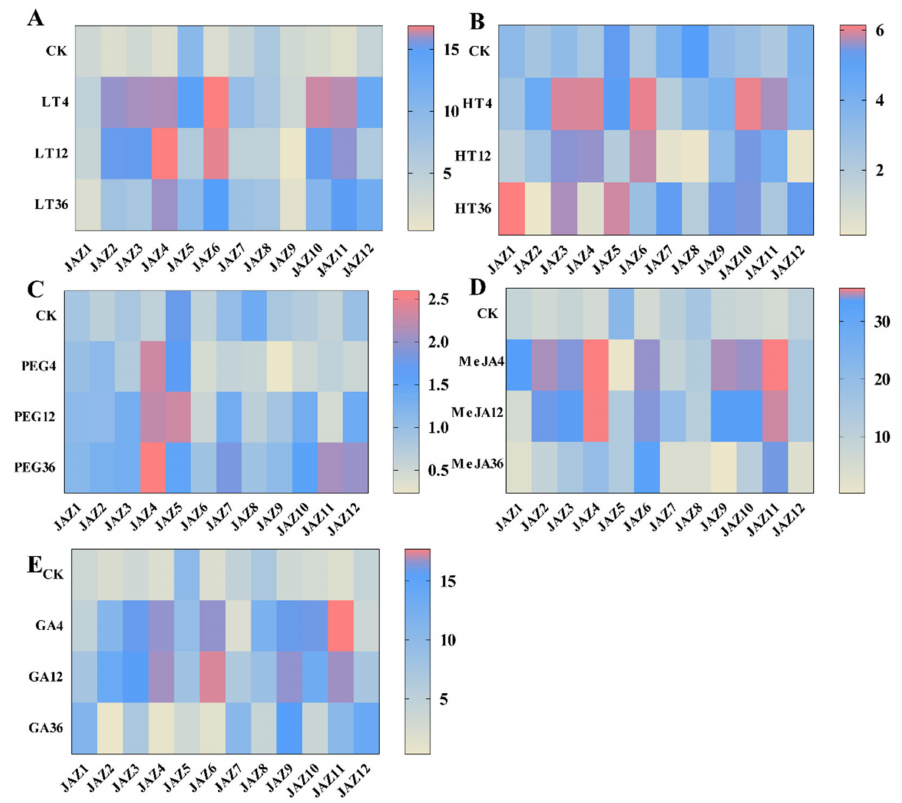
Figure 4. Expression heat maps of 12 CsJAZ genes under 5 treatments (low temperature (LT), high temperature (HT), polyethylene glycol 6000 (PEG 6000), jasmonate (MeJA), and gibberellin (GA)) in tea plants “Longjing43”. qRT–PCR strategy was used to analyze the relative expression level of each CsJAZ gene. A Expression heat maps of 12 CsJAZ genes under LT stress. B Expression heat maps of 12 CsJAZ genes under HT stress. C Expression heat maps of 12 CsJAZ genes under 10%PEG 6000 stress. D Expression heat maps of 12 CsJAZ genes under 100 µ M MeJA treatment. E Expression heat maps of 12 CsJAZ genes under 100 µ M GA treatment. The expression level of tea actin was used as the internal control to standardize the RNA samples for each reaction and the expression at 0 h was set as CK. The labels on the left side of each heatmap indicated the samples with di ff erent treatments and sampling time after treatments. Relative expression levels were shown in color as the scale. The data were from three biological